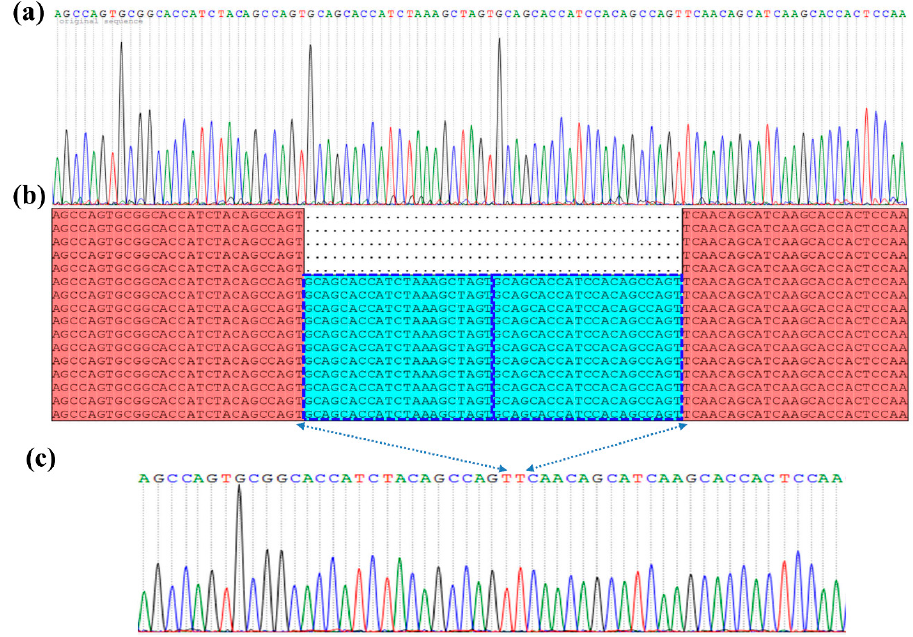
Figure 2. Identification of tandem repeat (TR) variations within multi-copy GH45 genes. ( a ) Clone sequencing results of TR regions in GH45_1, ( b ) Clustal analysis of GH45_1 and GH45_2 clone sequencing results; highlighted blue rectangles indicate the TR variations between GH45_1 and GH45_2 and ( c ) Clone sequencing results of TR regions in GH45_2; dashed double headed arrows indicate the position where 2 copies of TRs (21 bp) were deleted. Table 1. An overview of GH45 genes with different copies.